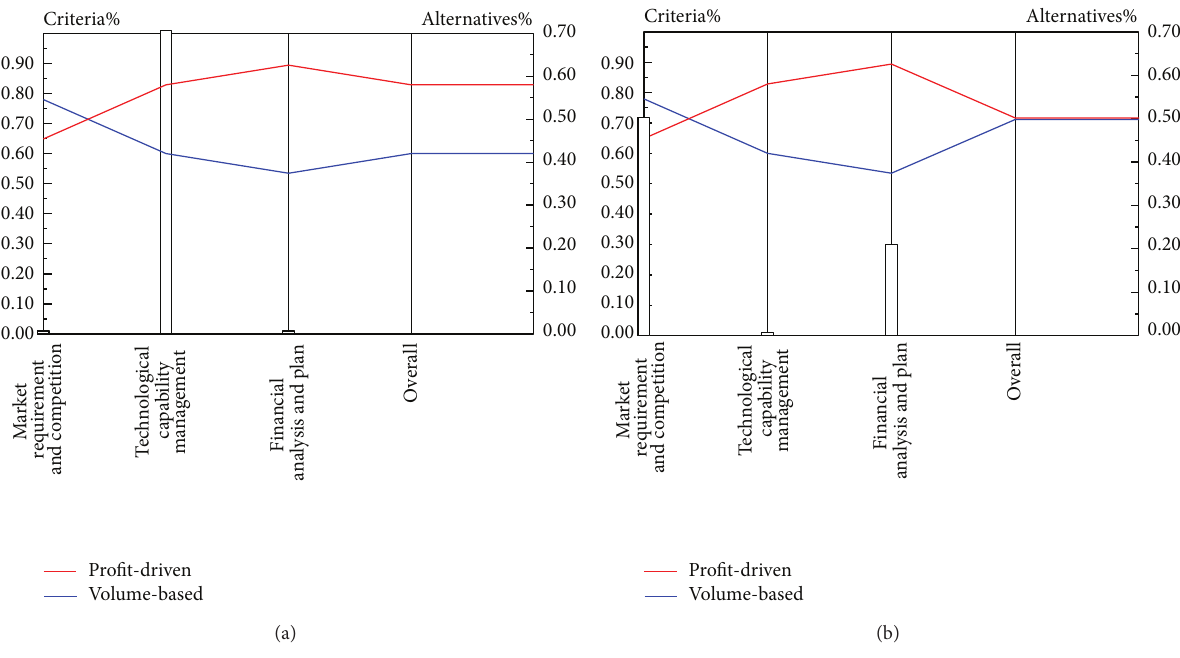
Figure 6: Sensitivity analysis with respect to financial analysis and planning.